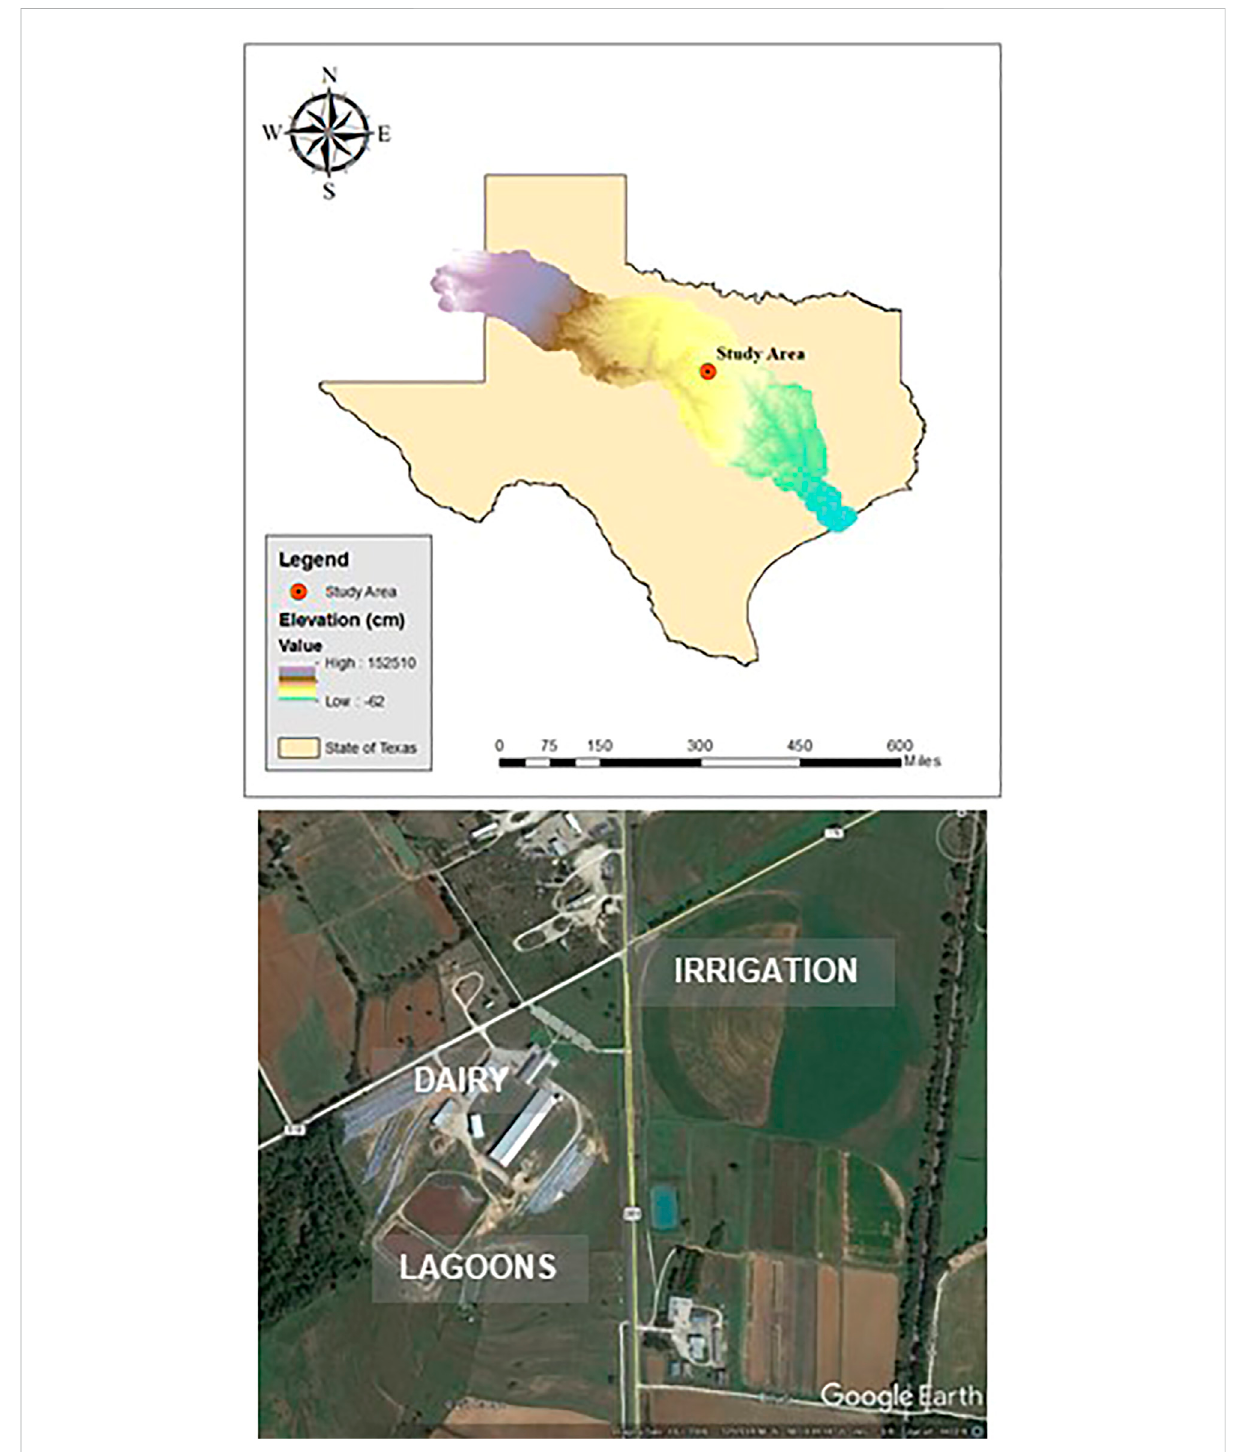
FIGURE 1 Study area: immediately north of Stephenville, Texas, in the Brazos River